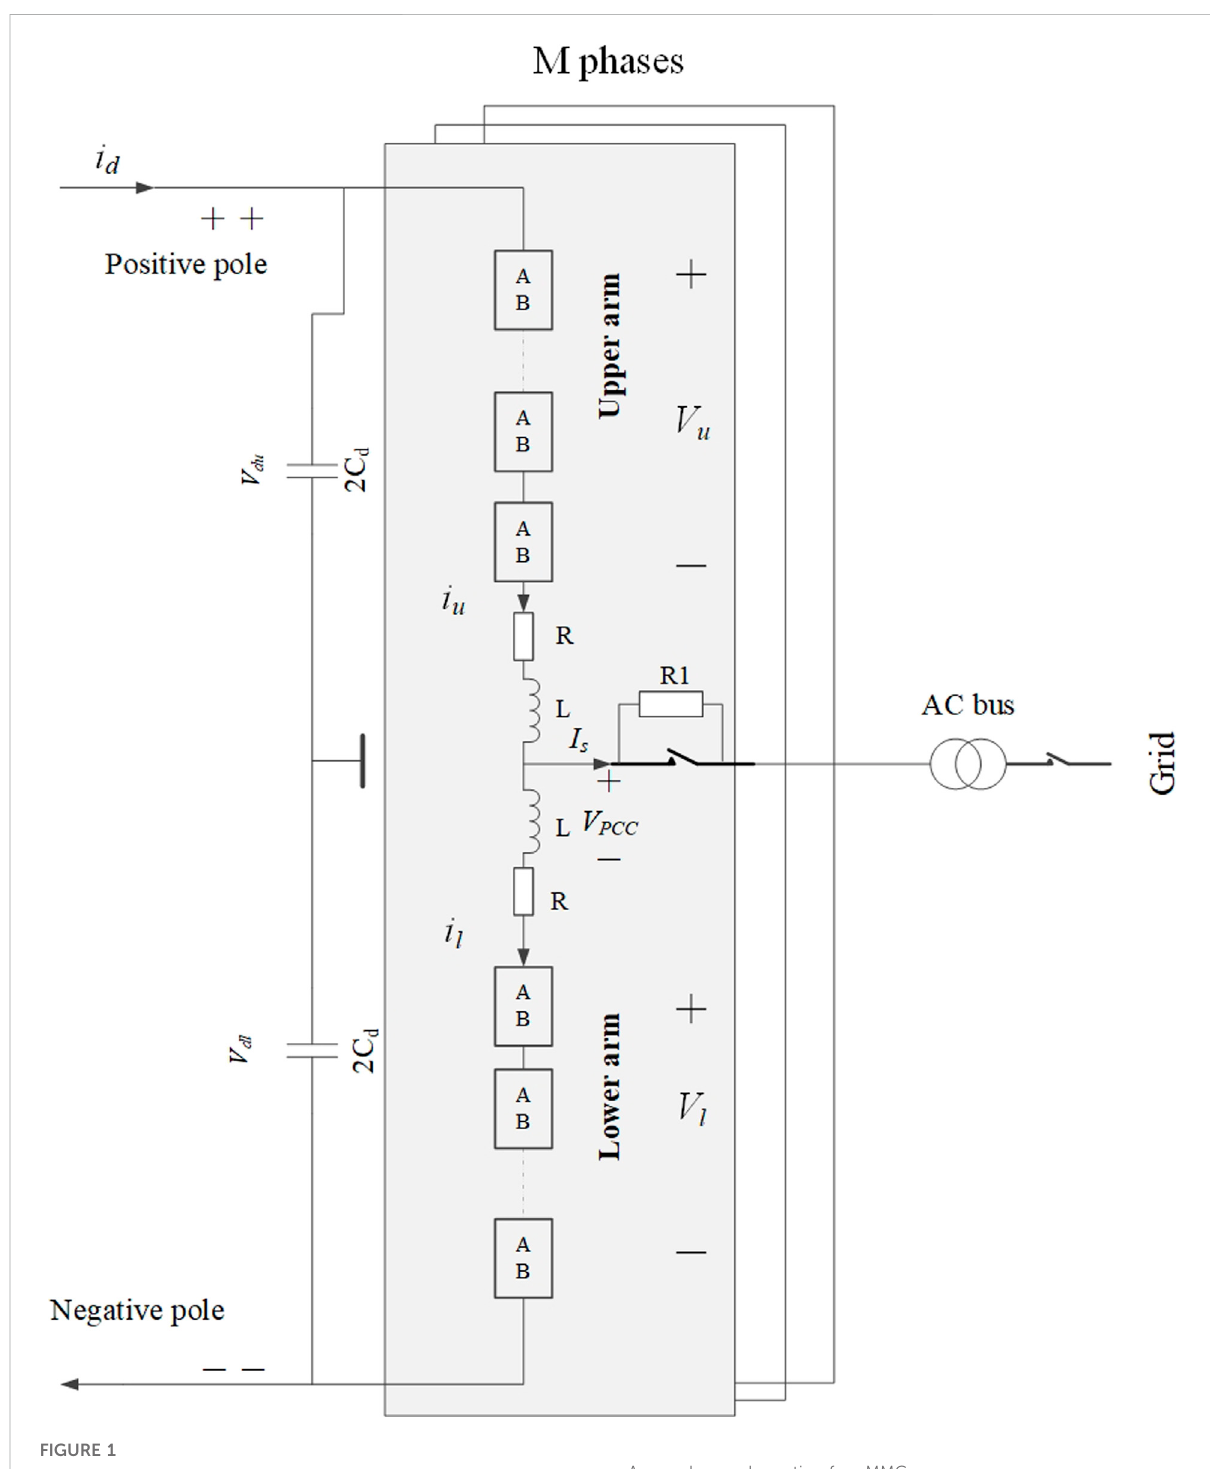
A per-phase schematic of an